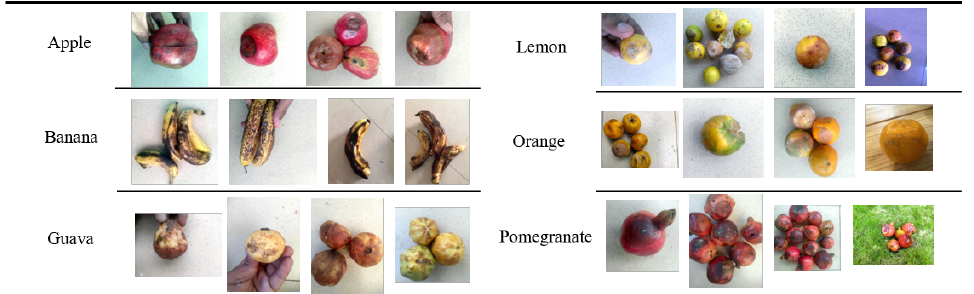
Figure 10. Examples of the FQ dataset on six categories.